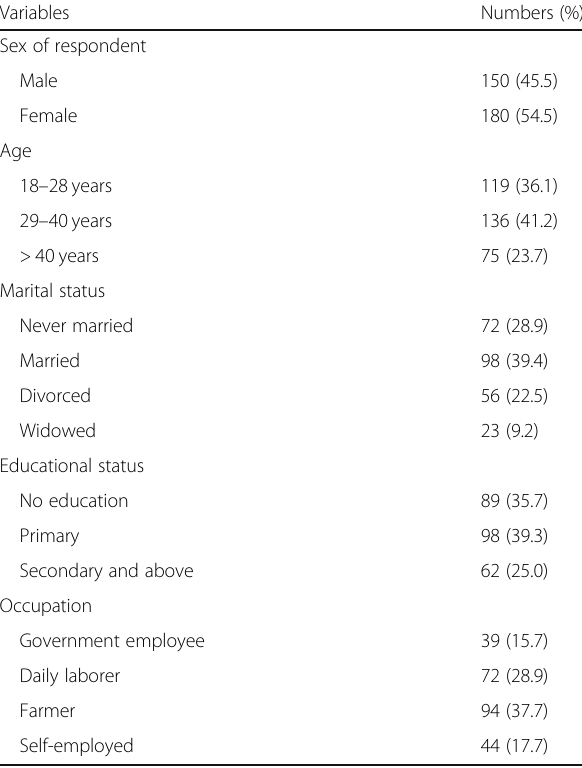
Table 1 Socio-demographic characteristics of patients included in the study